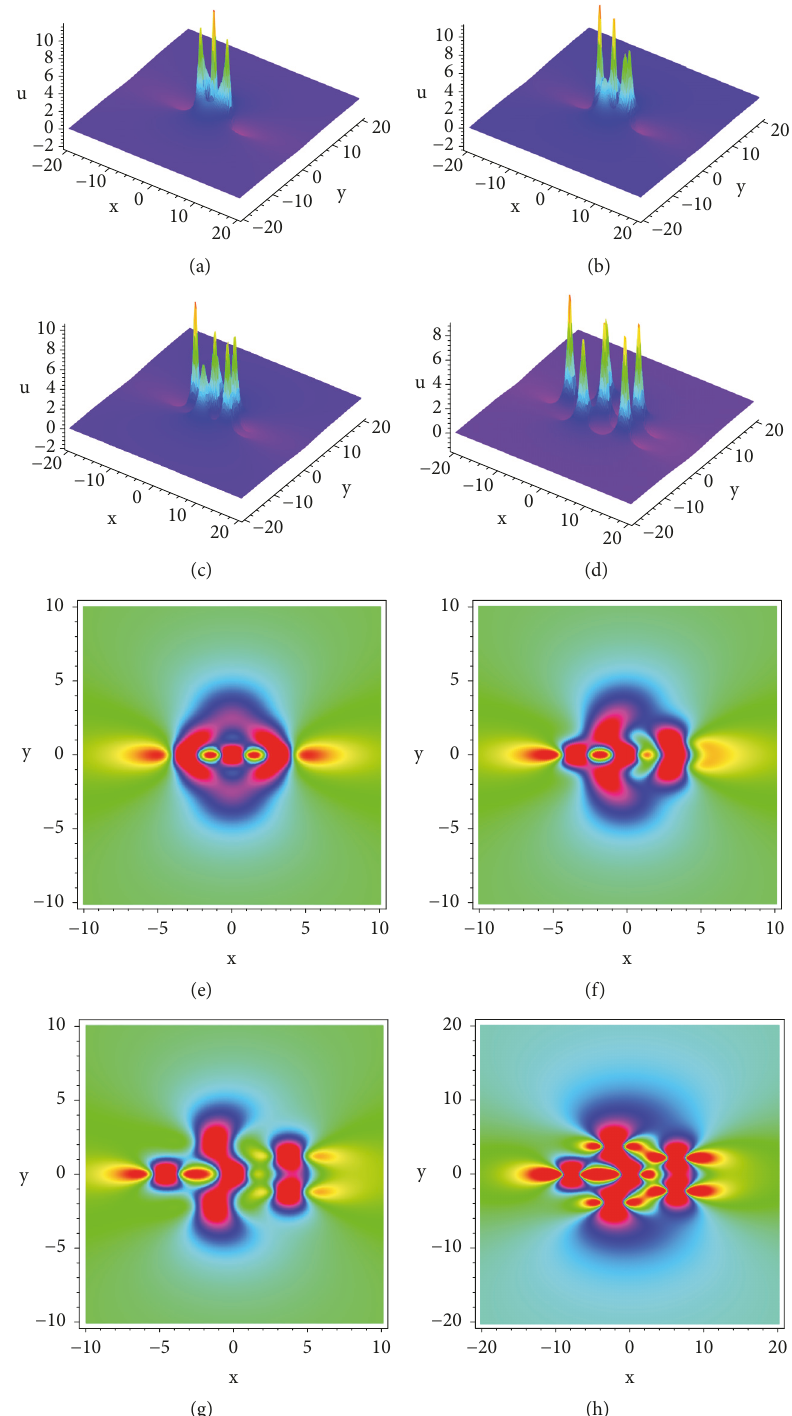
Figure 6: Plots (colored online) of 6-lump wave 𝑢 (17) with 𝑚 = 2, 𝑎 = 𝑏 = −2 . (a) Perspective view of the wave 𝑢(𝑥, 𝑦,0) with 𝛼 = 8,𝛽 = 10 , (b) perspective view of the wave 𝑢(𝑥,𝑦, 0) with 𝛼 = 800, 𝛽 = 1000 , (c) perspective view of the wave 𝑢(𝑥,𝑦, 0) with 𝛼 = 3000,𝛽 = 4000 , (d) perspective view of the wave 𝑢(𝑥,𝑦, 0) with 𝛼 = 3 × 10 4 ,𝛽 = 4 × 10 4 , (e) overhead view of the wave (a), (f) overhead view of the wave (b), (g) overhead view of the wave (c), and (h) overhead view of the wave